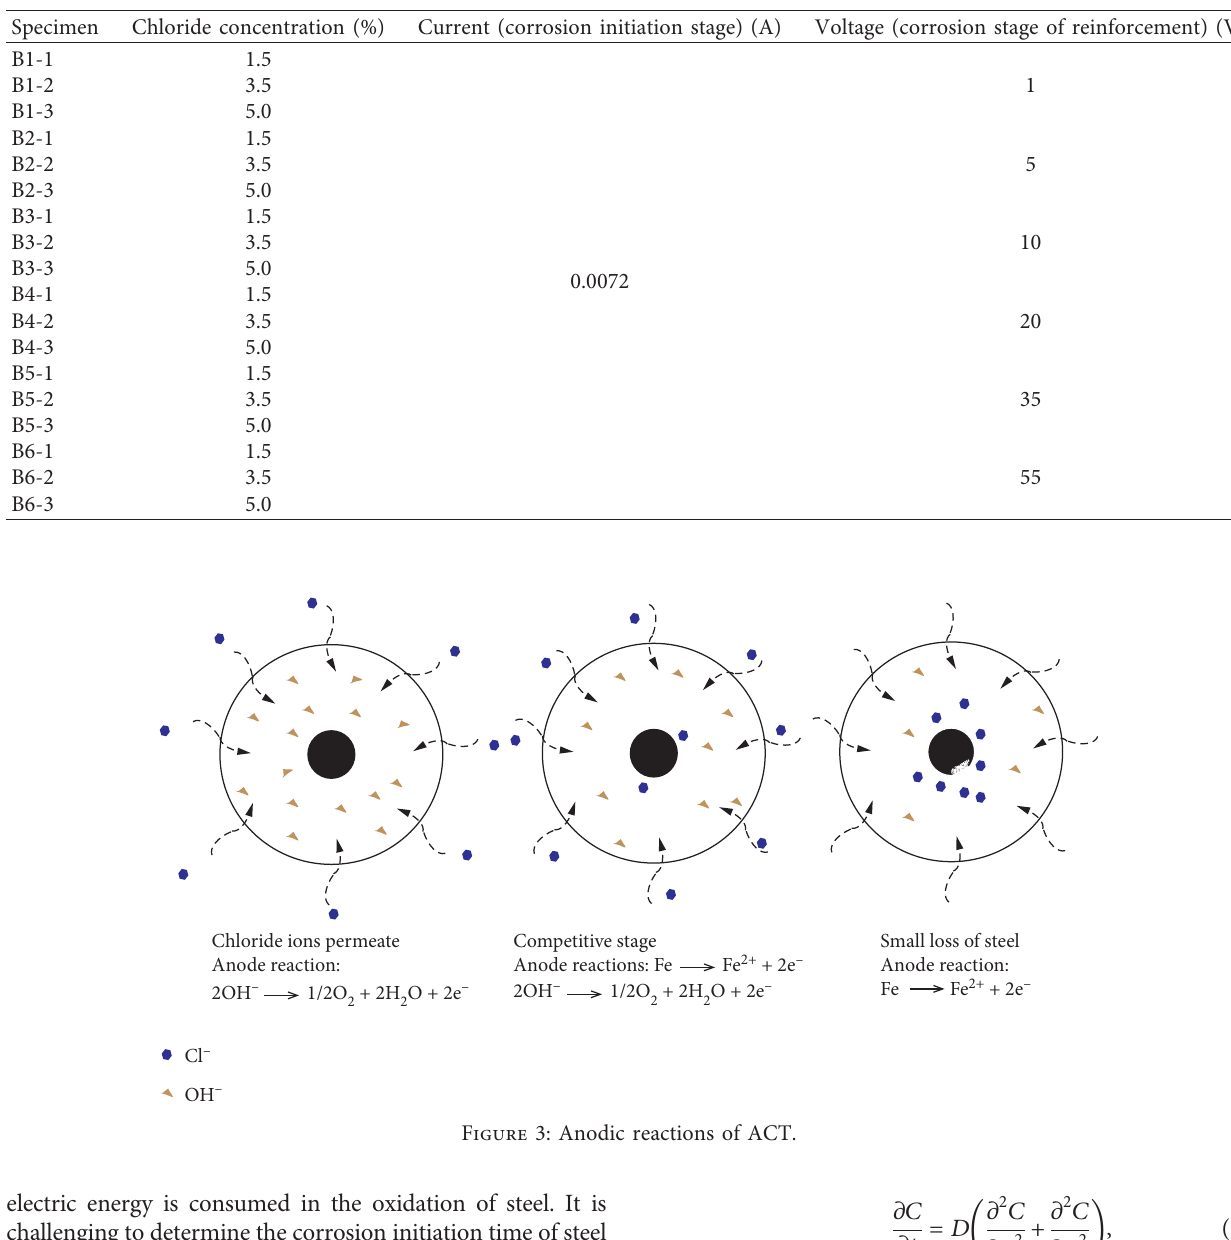
Figure 3: Anodic reactions of